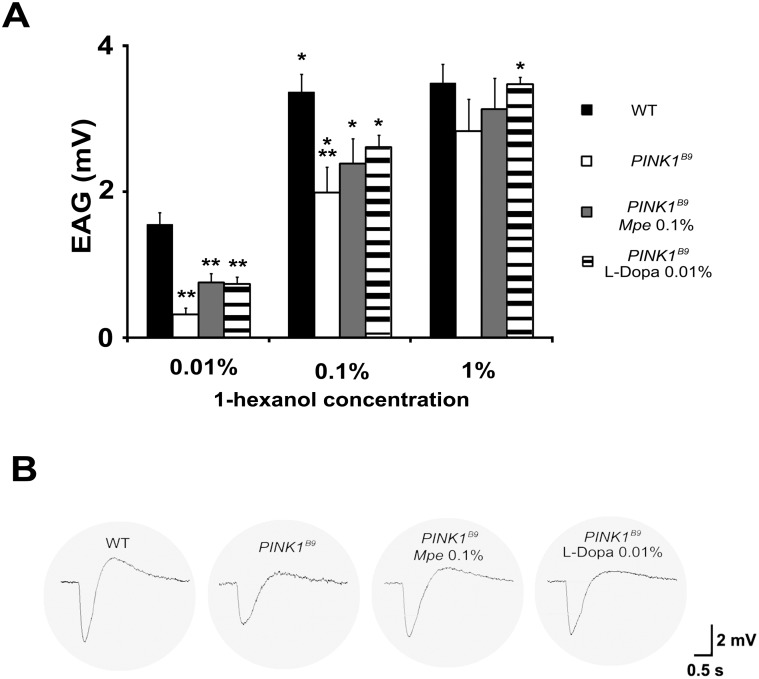
Electroantennogram responses to 1-hexanol.Histograms in (A) show the dose-response relationship and their differences in signal for olfactory stimulations in WT, untreated PINK1B9 and in Mpe (0.1%)- and L-Dopa (0.01%)-treated PINK1B9, recorded in flies from group II. As odor stimuli, the 1-hexanol was administered in a 3-step dose from 0.01 to 1% in hexane. Values are average + SEM. *indicates p<0.05 at one-way ANOVA followed by HSD post hoc test as compared to the previous concentration of the stimulus. **indicates p<0.05 at one-way ANOVA followed by HSD post-hoc test as compared to WT. (B) Samples of EAGs recordings in response to 1-hexanol 0.1%.